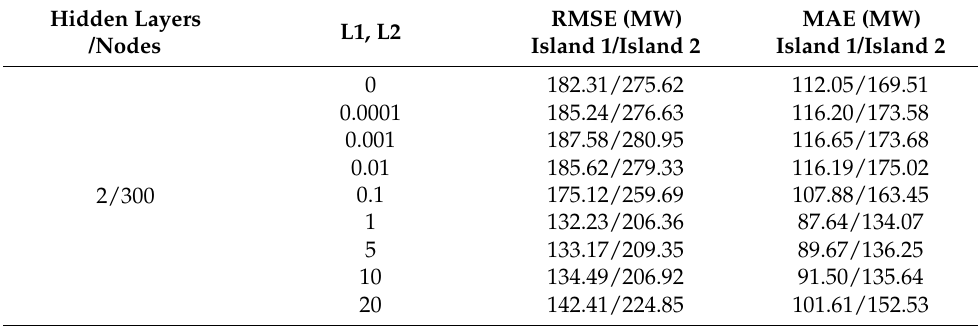
Table 1. Performance of trained model with L1 and L2 regularization techniques.